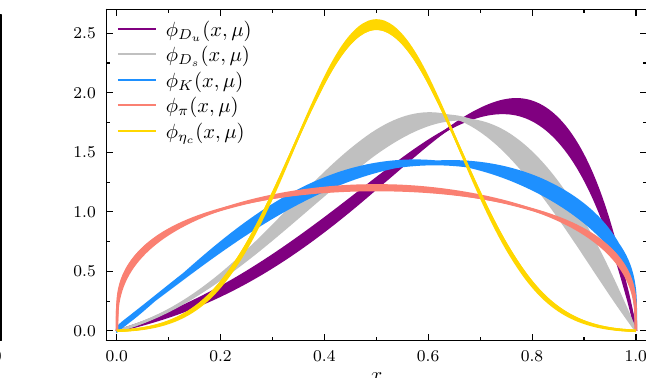
Fig. 5 Distribution amplitudes on the light front at a renormalization point μ = 2 GeV. Left panel: φ π ( x ,μ) , φ K ( x ,μ) and φ asy ( x ) = 6 x ¯ x is the asymptotic LCDA. Right panel: Comparison of the light-meson